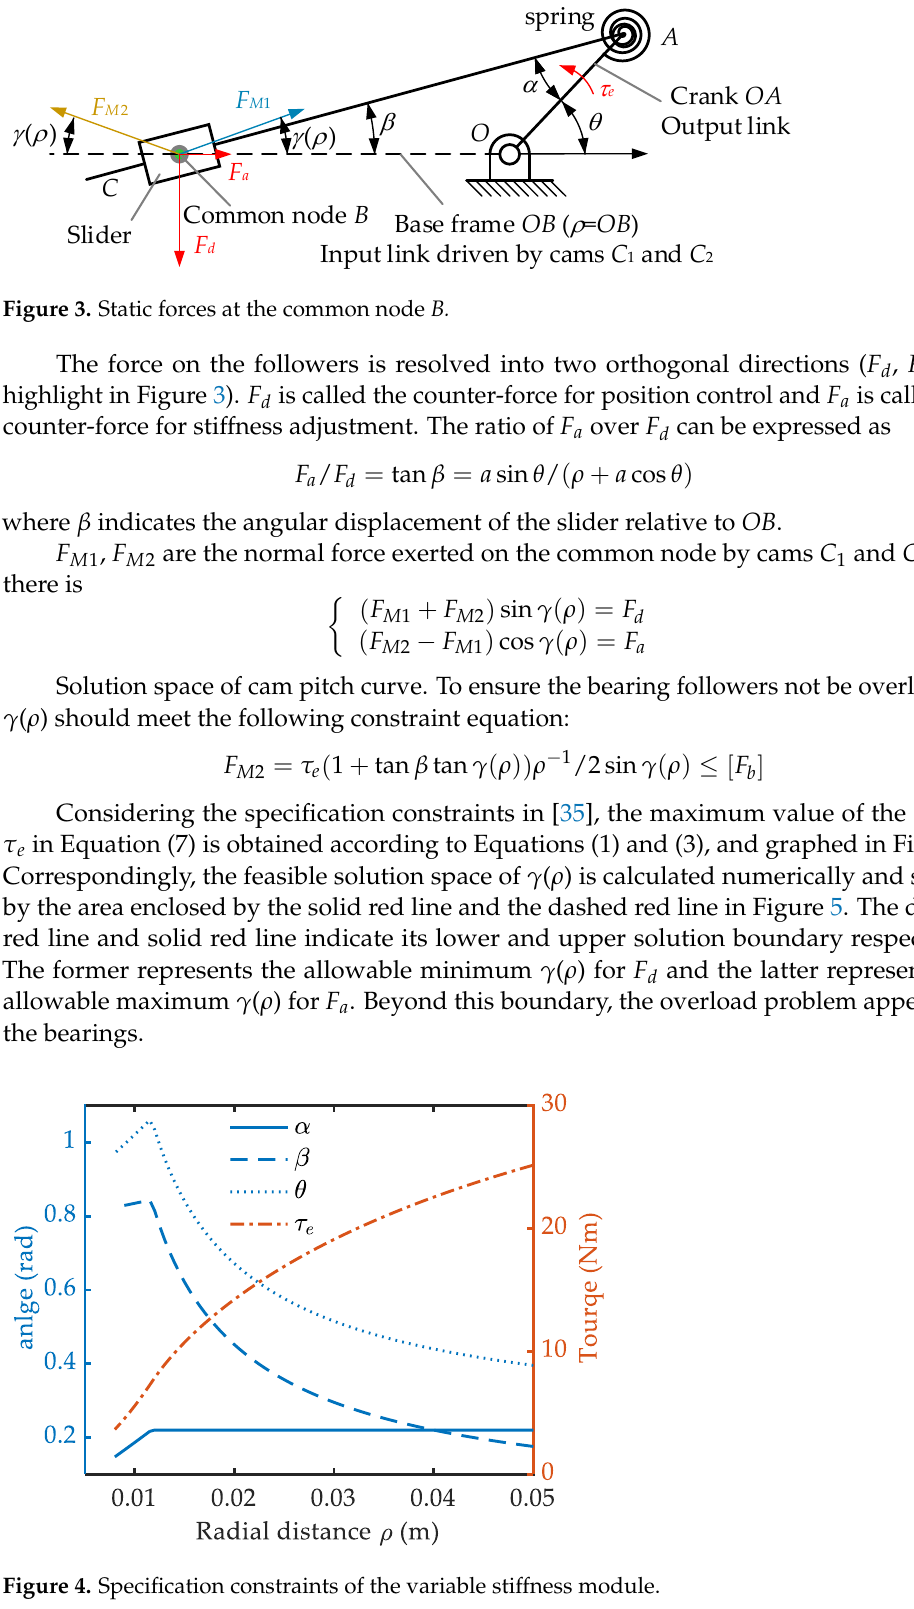
Figure 5. Solution space constrained by bearing’s rated load. There appears a local shrinkage phenomenon near ρ = 0.014 m on the solution space. This is caused by the change of the main factors determining γ ( ρ ). When ( ρ < 0.014 m), a small γ ( ρ ) is allowed with low stiffness. Afterward, the stiffness increases quickly and leads to a sharp increase of γ ( ρ ). After the shrinkage point, the decreasing ρ − 1 and β be- come the dominant factors and the γ ( ρ ) decreases slowly. The upper boundary curve ex- hibits an antisymmetric feature as the second solution for Equation (7). The two together generate the shrinkage phenomenon. The degree of the shrinkage is decided by the bear- ing’s rated load. The feasible solution space would broaden outward slightly with a larger bearing ([ F b ] = 950 N), indicated by the grey area in Fig 5. But it would shrink inward seriously with a smaller bearing ([ F b ] = 750 N), as indicated by the yellow area in Fig 5. The difference is caused by the nonlinearity of the F M 1 over γ ( ρ ) in Equation (6). This trend is more significant near shrinkage point as the β in this interval is larger, as shown in Figure 4. So, a favorable choice of the cam follower bearing should be based on the me- chanical property of the variable stiffness module. Bearing a too small rated load would limit the solution space for the cam reconstruction design and too large one does not help much but increases the curvature radius. Pressure angle constrained by undercutting . The minimum curvature radius should be large than the radius of the cam followers. So, any feasible γ ( ρ ) in Figure 5 should meet the following undercutting constrained equation: ( ) ( ) (8) where D indicates the diameter of the cam followers, γ’ ( ρ ) is the derivative of γ ( ρ ) over ρ .